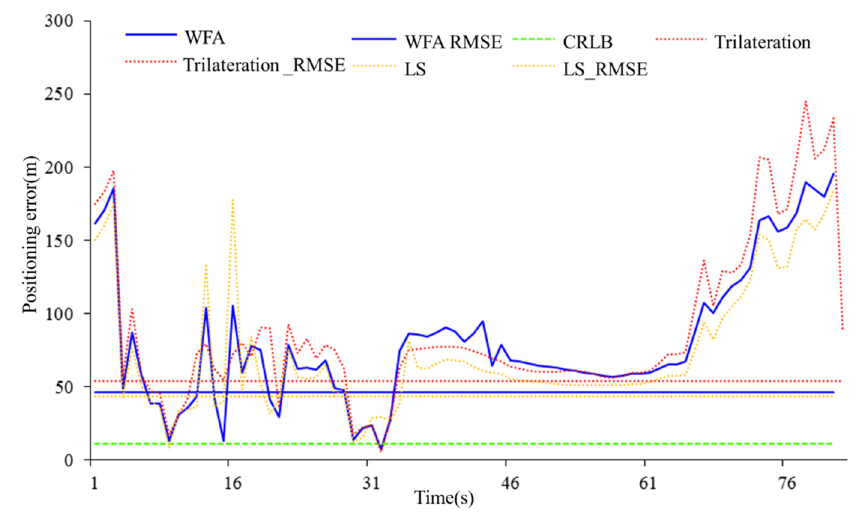
Figure 5. WFA fusion method analysis of the positioning accuracy.